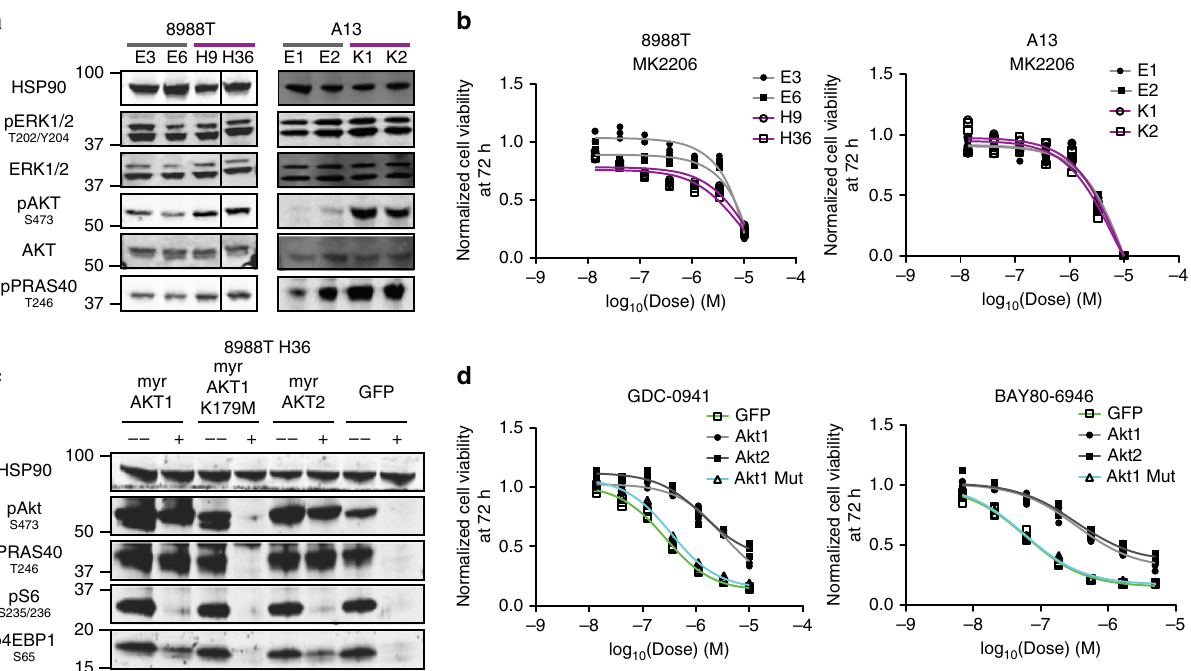
Fig. 4 PI3K inhibition functions through AKT-dependent and -independent mechanisms. a Western blot showed stable pERK1/2 but increased pAKT and pPRAS40 levels in 8988T and A13 KRAS de fi cient (purple) cells, consistent with PI3K/AKT pathway activation. HSP90 is loading control. b Dose-response curves of 8988T and A13 KRAS intact (gray) and de fi cient (purples) clones to the pan-AKT inhibitor MK2206. Each replicate ( n = 3 for each dose) and curve fi t are shown. c Western blot showed sustained phosphorylation of AKT and downstream targets (PRAS40, S6, and 4EBP1) only in myr-AKT1- and myr-AKT2- expressing cells but not in myr-AKT1 (K179M)- or control GFP -expressing cells following 4 h of 2 μ M GDC-0941 treatment. d Dose-response curves of cell lines in c treated with GDC-0941 and BAY80-6946 demonstrated a marked decrease in PI3K sensitivity with myr-AKT1 or myr-AKT2 overexpression. Each replicate ( n = 3 for each dose) and curve fi t are